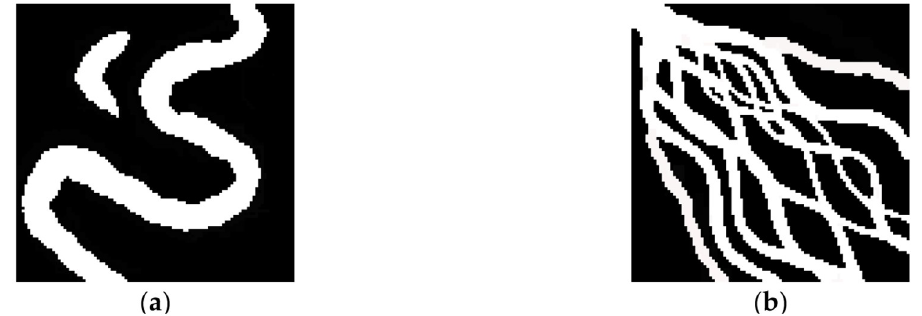
Fig 7. Training image data sets: (a) meandering river model (100 � 100); (b) delta plain model (100 � 100).